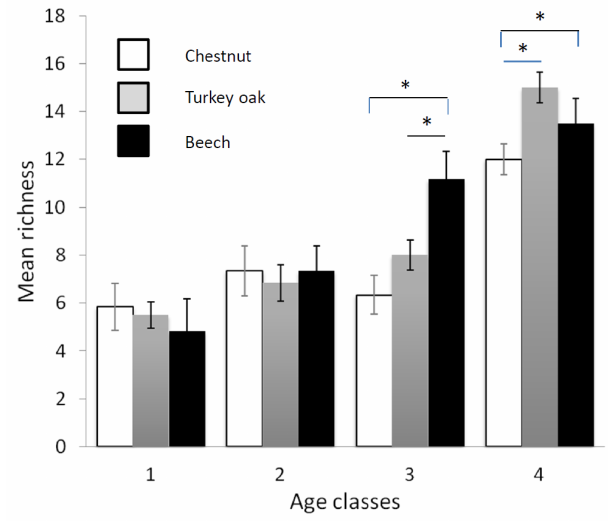
Figure 3. Mean richness of forest bird species (see Table 2) in the different forest habitats (age class and tree composition). Chestnut in white, Turkey oak in grey and beech in black. Error bars represent the standard